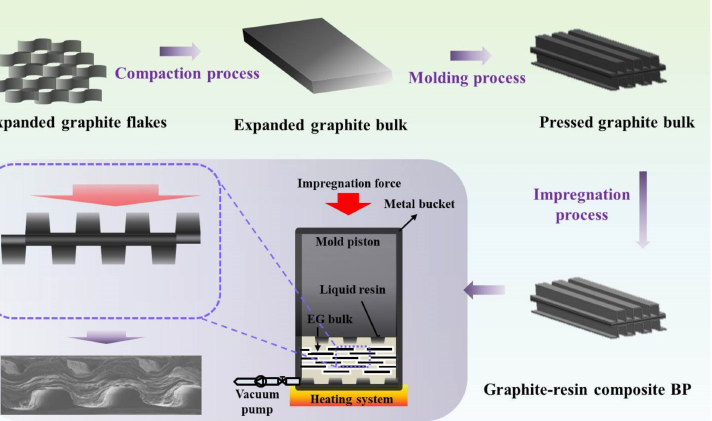
Figure 1. Schematic illustrations of the fabrication process of composite BPs following the compaction process, molding process, and impregnation